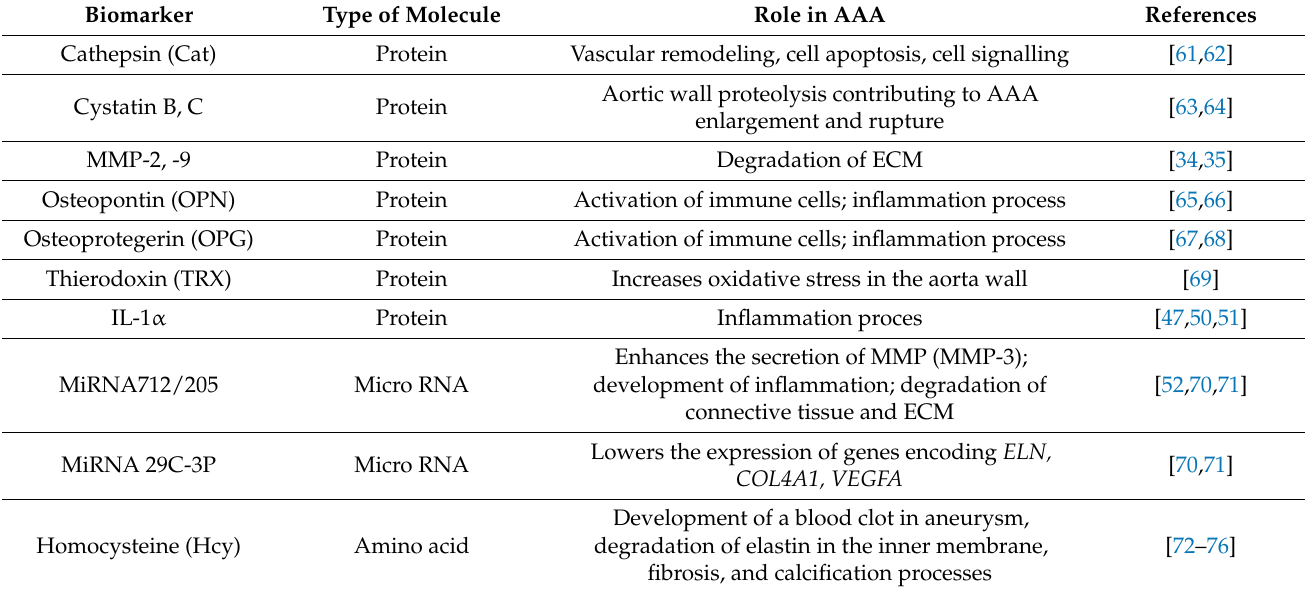
Table 3. A list of the most important markers involved in the formation of